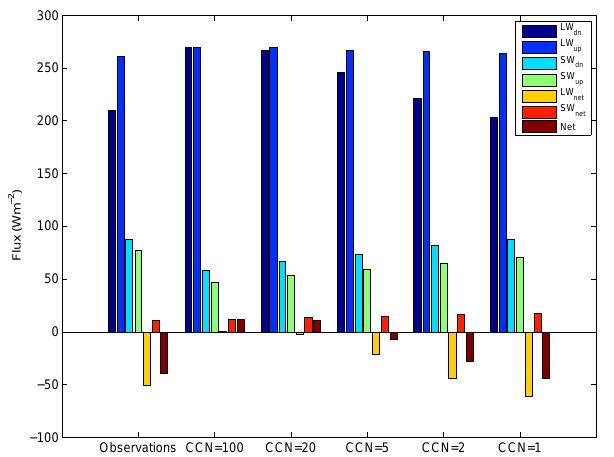
Fig. 10. Mean radiative flux observations between 05:00 and 06:00UTC, DoY 245 and radiative flux diagnostics at t + 6h from the SCM run initialised at 23:30UTC, DoY 244.